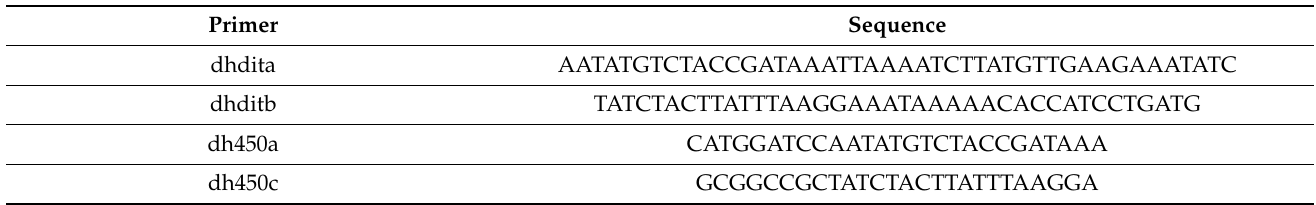
Figure 2. Construction of the pYES2 -DhDIT2 plasmid. Experimental strategy to construct the plasmid expressing the DhDIT2 gene used to transform the S. cerevisiae BY4742 parent strain and the dit2 ∆ mutant. Created with BioRender.com. Table 1. Primers used for plasmid